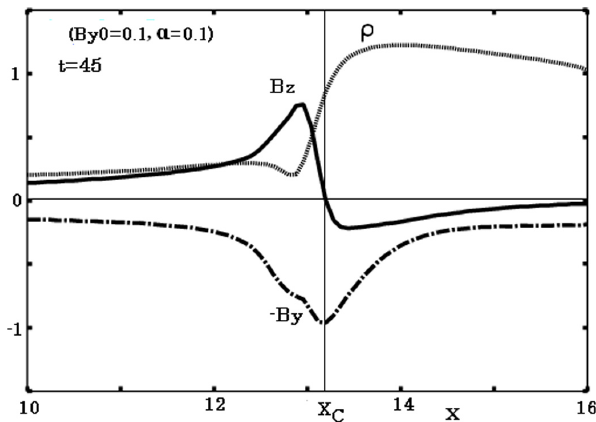
Fig. 6. Profiles of the plasma density ρ , − B y and B z at t = 45 along the x-axis around the plasmoid center X C for the case of B y0 = 0 . 1 and α = 0 . 1.